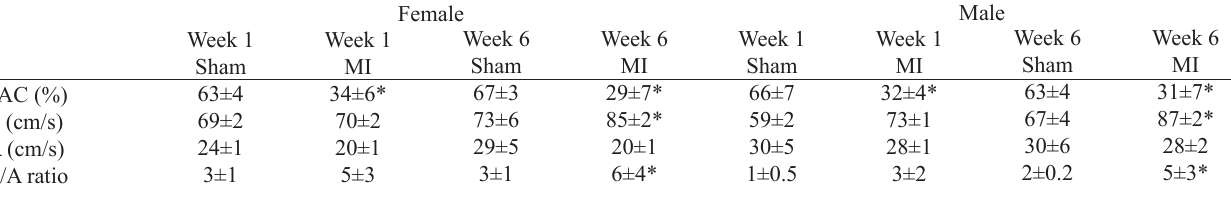
Table 2. Echocardiographic functional parameters for female and male rats post-MI.